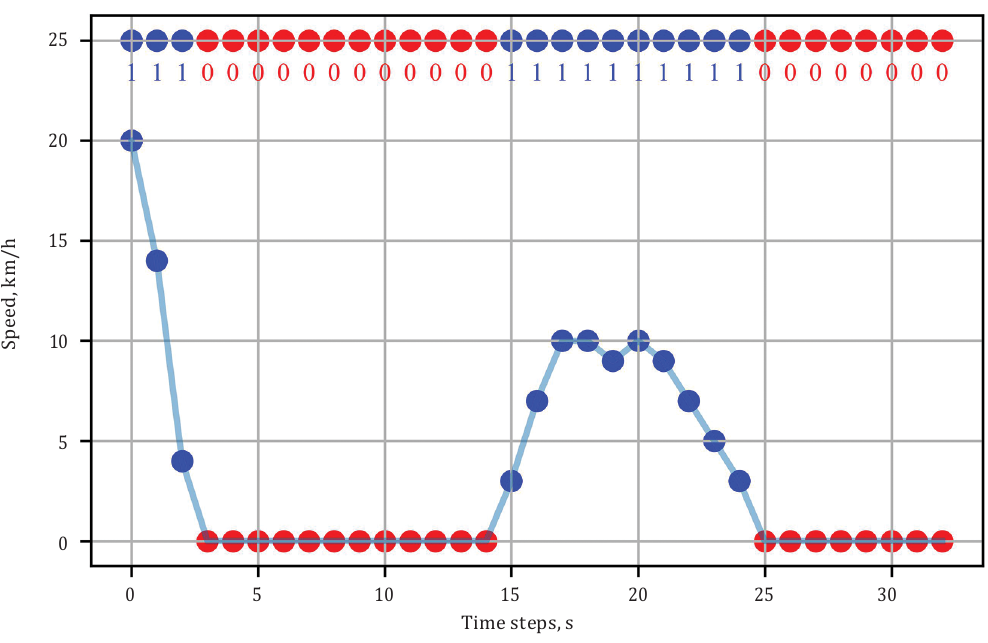
Figure 8. The start and end point of